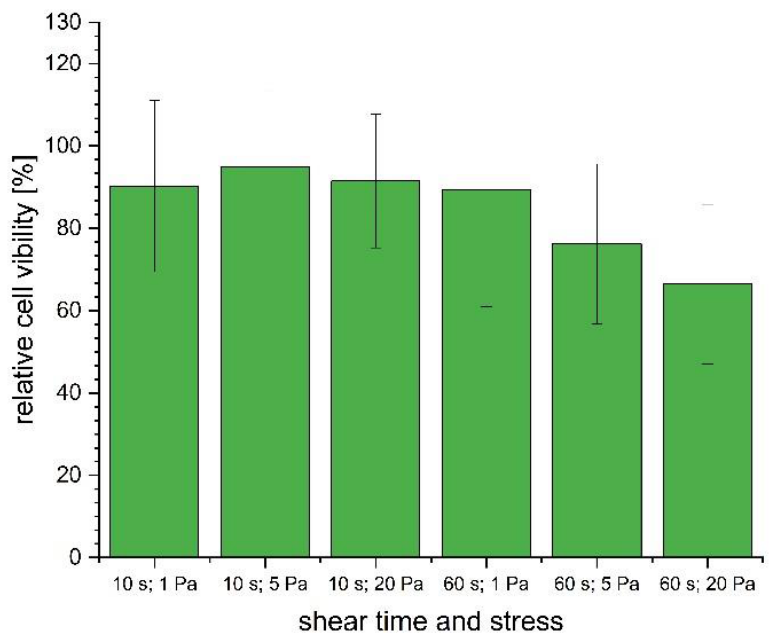
Figure 5. Viability of 1.1B4 cells determined using the CellTox Green assay at different shear intensities (1–20 Pa) and exposure times (10 s and 60 s) in cell culture medium with an 80- µ m gap at 37 ◦ C ( n = 3). The sheared samples were normalized to untreated cells (100%). The shear-dependent behavior of the carrier material and corresponding bioink (loaded with 10 5 –10 6 cells · mL − 1 ) at 37 ◦ C showed a decrease in viscosity as the shear rate increased (Figure 6A), indicating that shear thinning occurred in all samples. The viscosity of the carrier material (Figure 6, black line) started at 30,603 ± 1145 mPa · s (1 s − 1 ) and declined to 770 ± 20 mPa · s (1200 s − 1 ). Adding cells reduced the